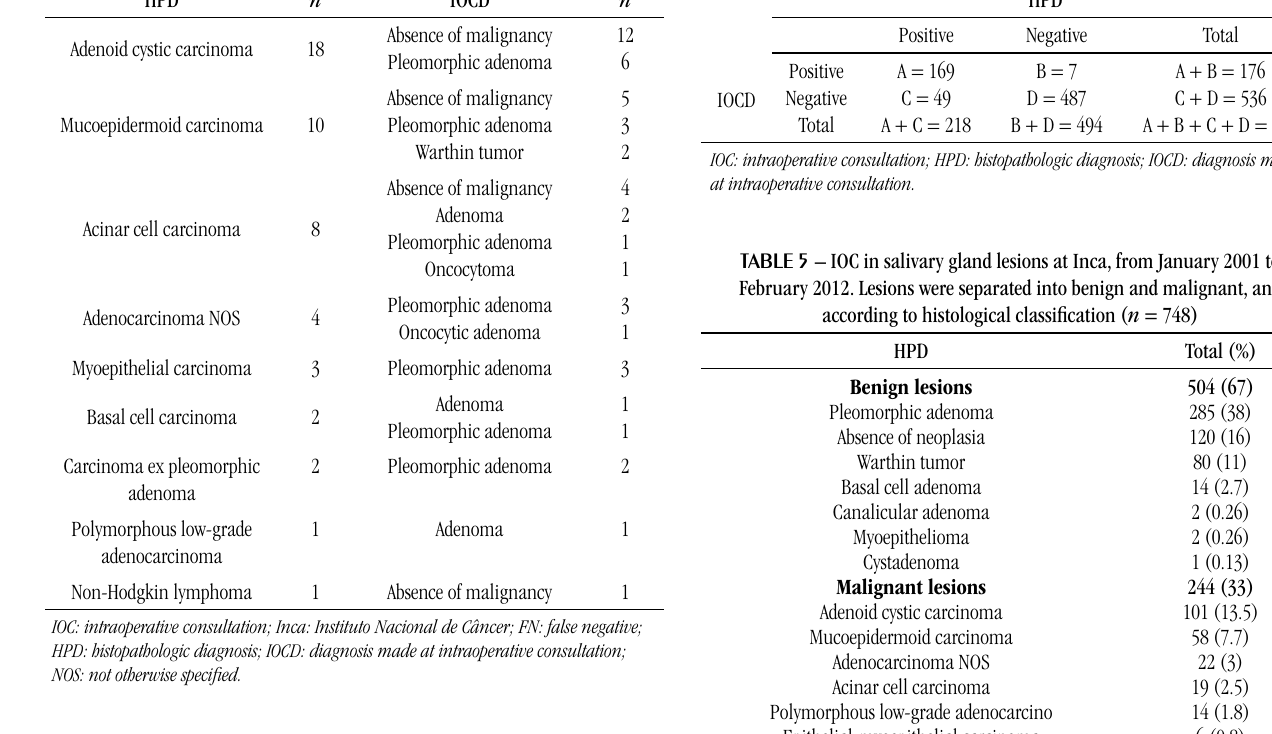
taBLE 3 – IOC in salivary gland lesions at Inca, from January 2001 to December 2012. Indeterminate cases ( n = 36)